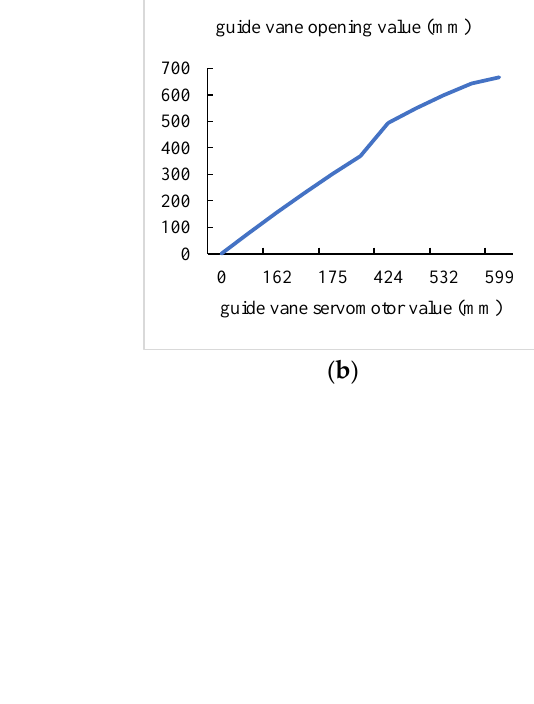
360 Table A5. Parameter setting of simulation experiment. Parameter